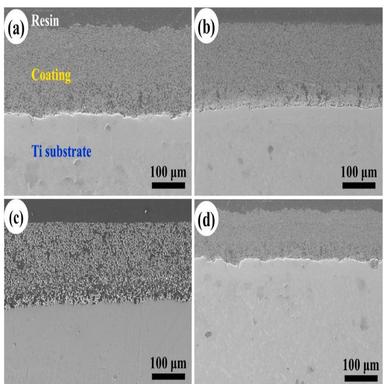
Cross-sectional morphology of the TiO2 coating sintered at different temperature for 1 h, (a) 800 ◦C, (b) 900 ◦C, (c) 1000 ◦C, and (d) 1100 ◦C.